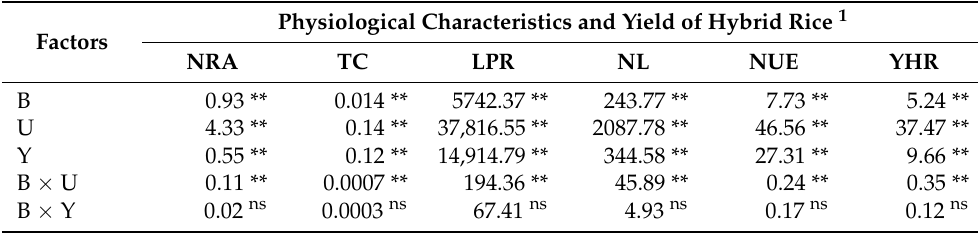
Table 3. Means square of the ANOVA for physiological characteristics and yield of hybrid rice. Physiological Characteristics and Yield of Hybrid Rice Factors